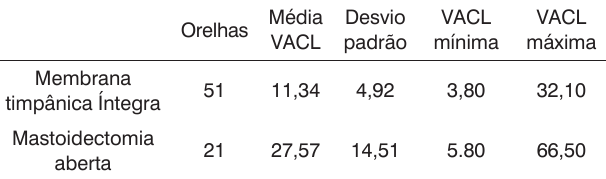
Tabela 2. Resultado das médias da VACL na estimulação fria de todas as orelhas com membrana timpânica íntegra e com mastoidectomia